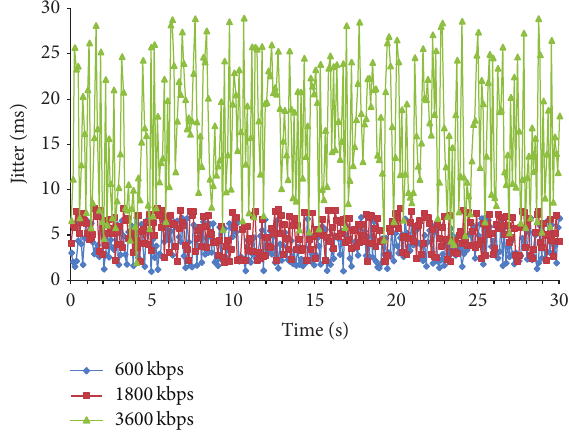
Figure 7: Jitter of different streams using different